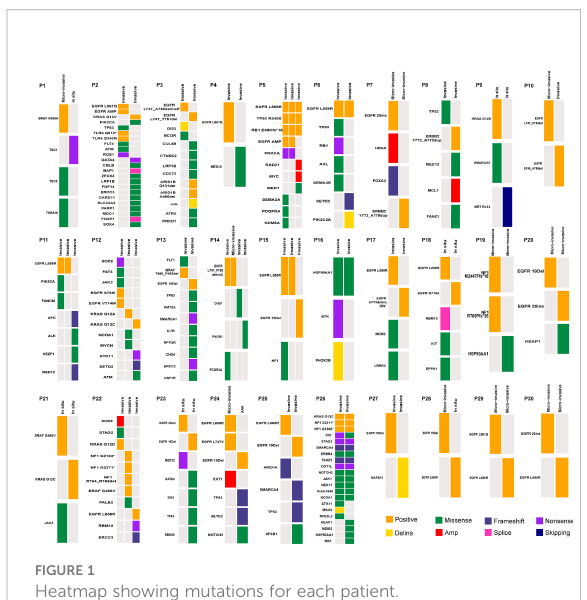
FIGURE 1 Heatmap showing mutations for each patient.